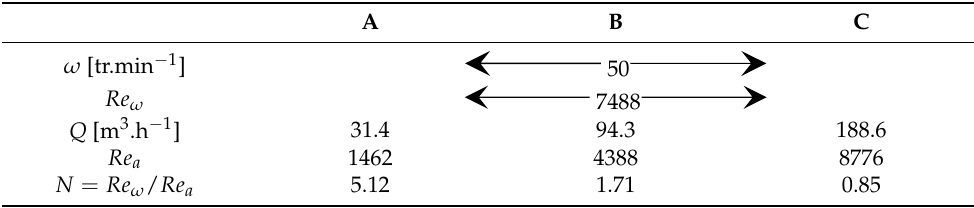
Table 1. Parameters studied in the numerical simulations for the different cases A, B, and C. A B A B A B C A A B ω [tr.min − 1 ] Re ω